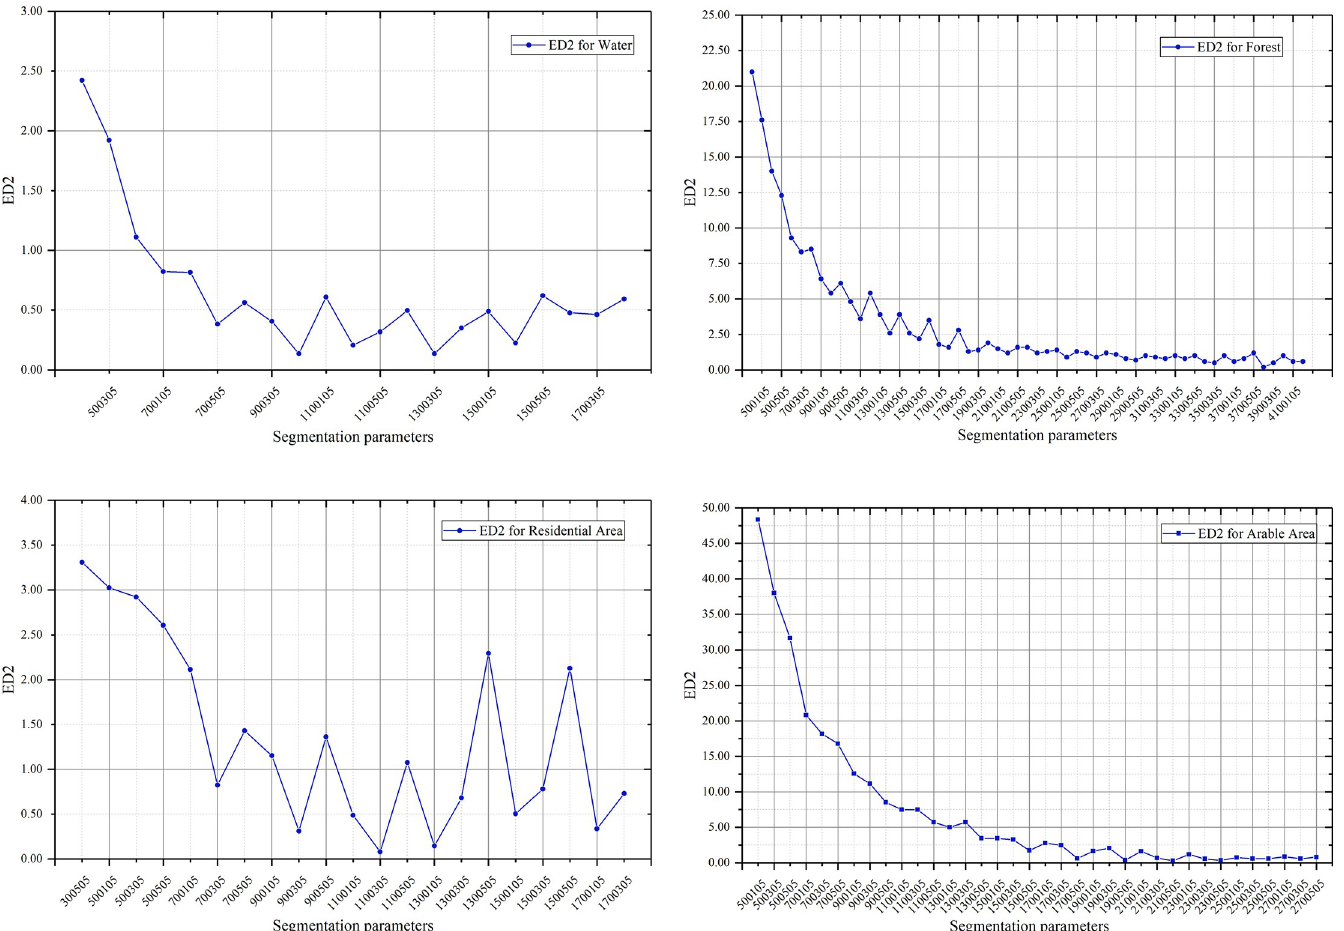
Fig 3. ED2 curves for 4 types of features. (a) ED2 curve of water. (b) ED2 curve of woodland. (c) ED2 curve of residential. (d) ED2 curve of arable land.